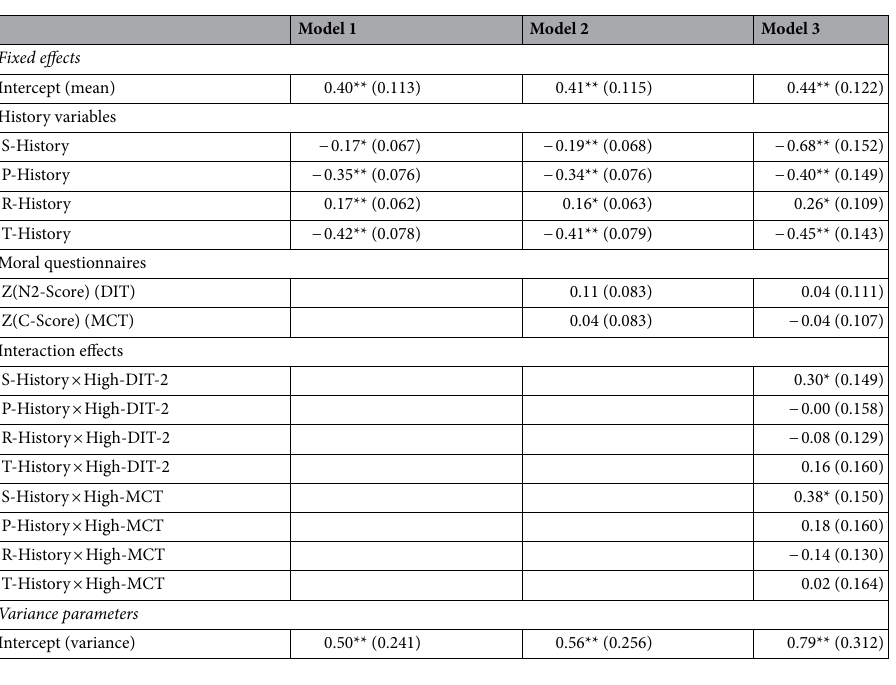
Table 1. Parameter estimates of the mixed-effects logistic regression models to predict cooperative behavior in the prisoner’s dilemma. Estimates are reported on the log-odds scale. Model 1 includes only the history variables as predictors; Model 2 includes both the history variables and the scores on the moral questionnaires; Model 3 adds the interactions. Z(N2-Score) and Z(C-Score) are the standardized N2-Score and C-Score, respectively, based on the sample means and variances. High-DIT-2 and High-MCT are binary variables with a value of 1 for N2-Scores and C-Scores above their respective median. The standard error associated with the estimated effect is shown between parentheses. *( p < 0.05) and **( p < 0.01) indicate that the estimate is significantly different from